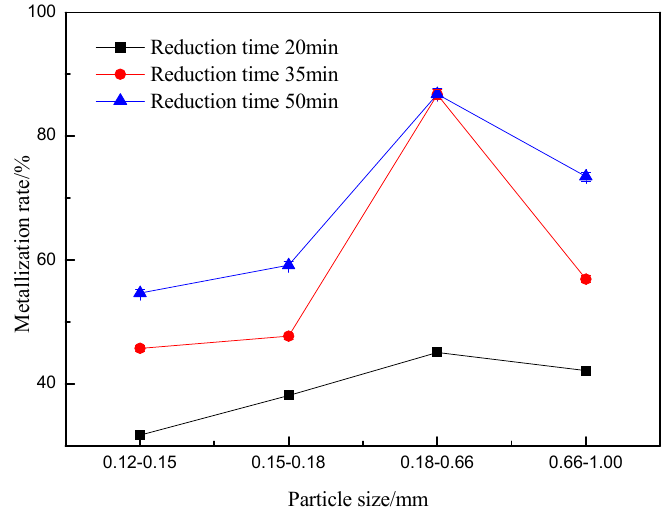
Figure 7. Trend of the metallization rate with changing particle sizes when the OMC fine iron ore is reduced by pure carbon monoxide at 0.2 MPa, 1023 K, 0.8 m/s after 20 min, 35 min, and 50 min.